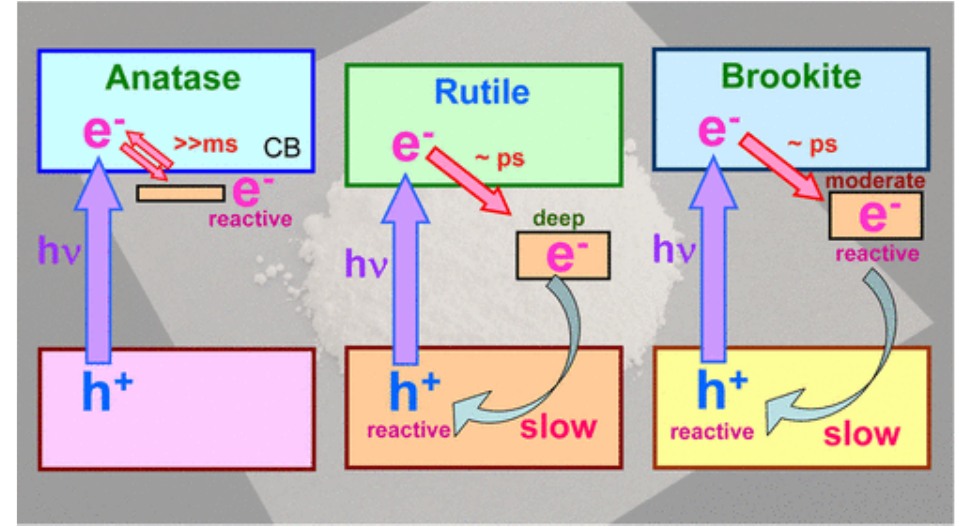
Figure 3. Schematic representation of electron trapping sites in anatase, rutile and brookite. CB: conduction band. Reproduced from reference [57] with permission of the American Chemical Society, 2017.